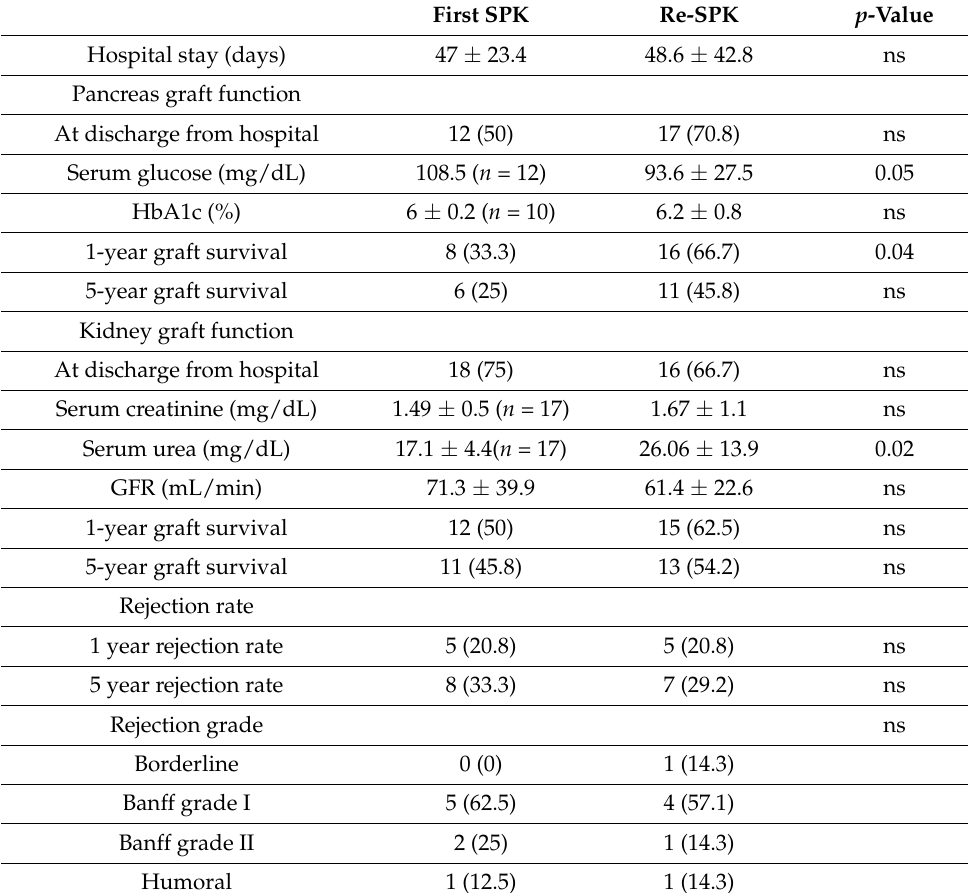
Table 3. Graft survival and rejection rates after Re-SPK.